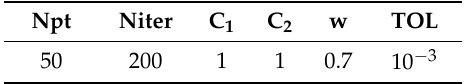
Table 3. Particle swarm tuning parameters used to perform simulations.